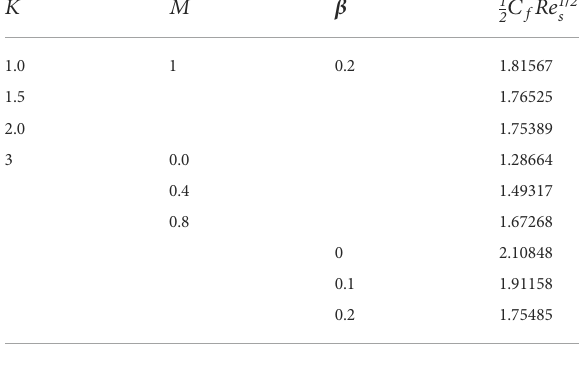
TABLE 2 Friction co-ef fi cient for various values M , K , and β . K